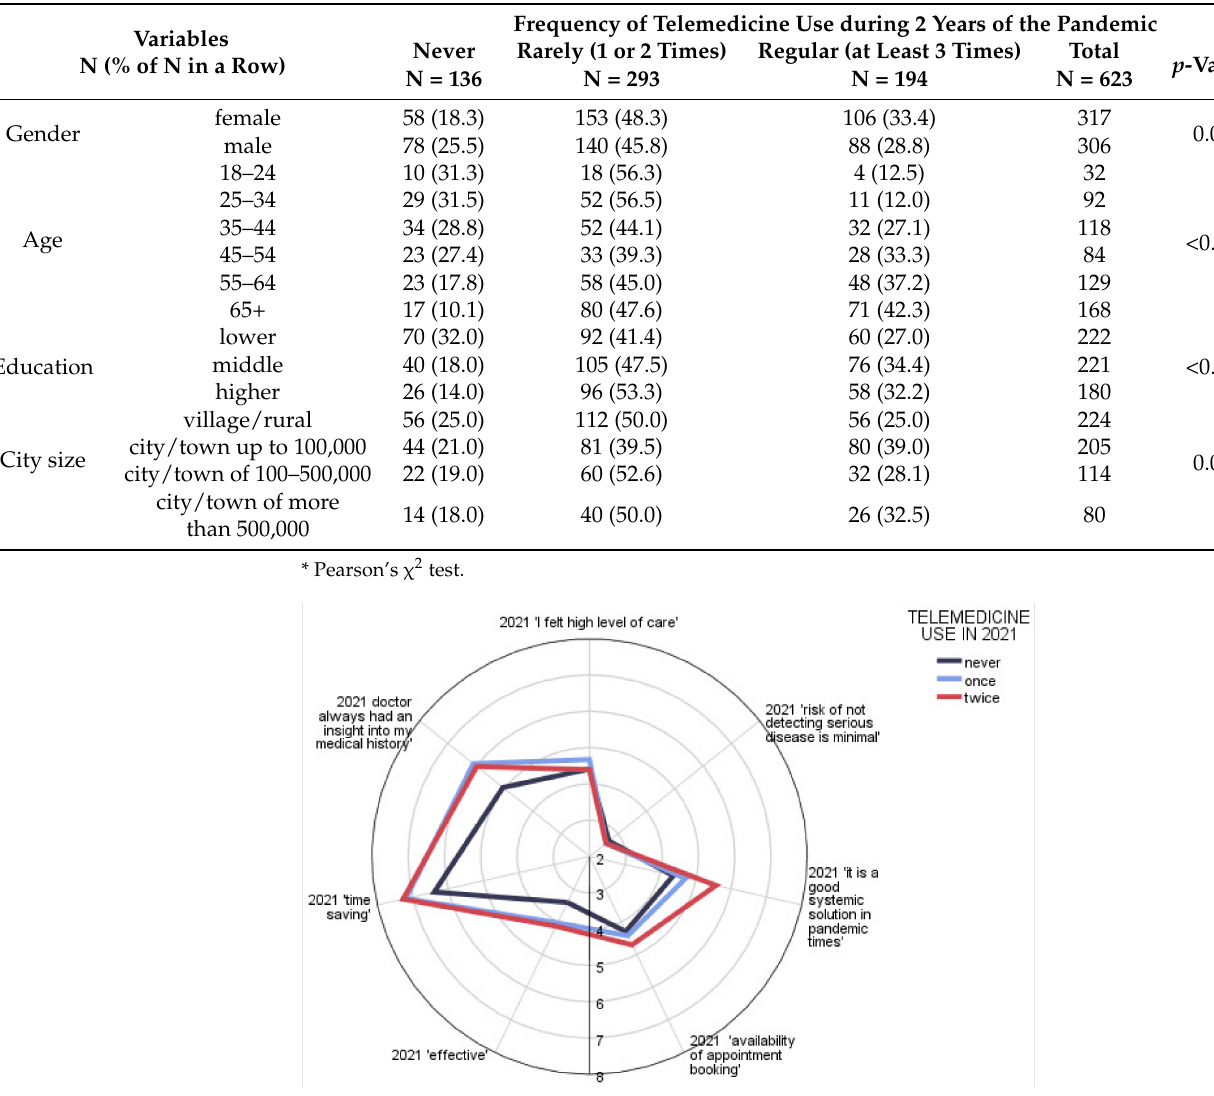
Figure 2. Patient opinion on telemedicine after year 1 of the pandemic. Table 2. Results of testing comparisons of telemedicine assessments after the first year of the